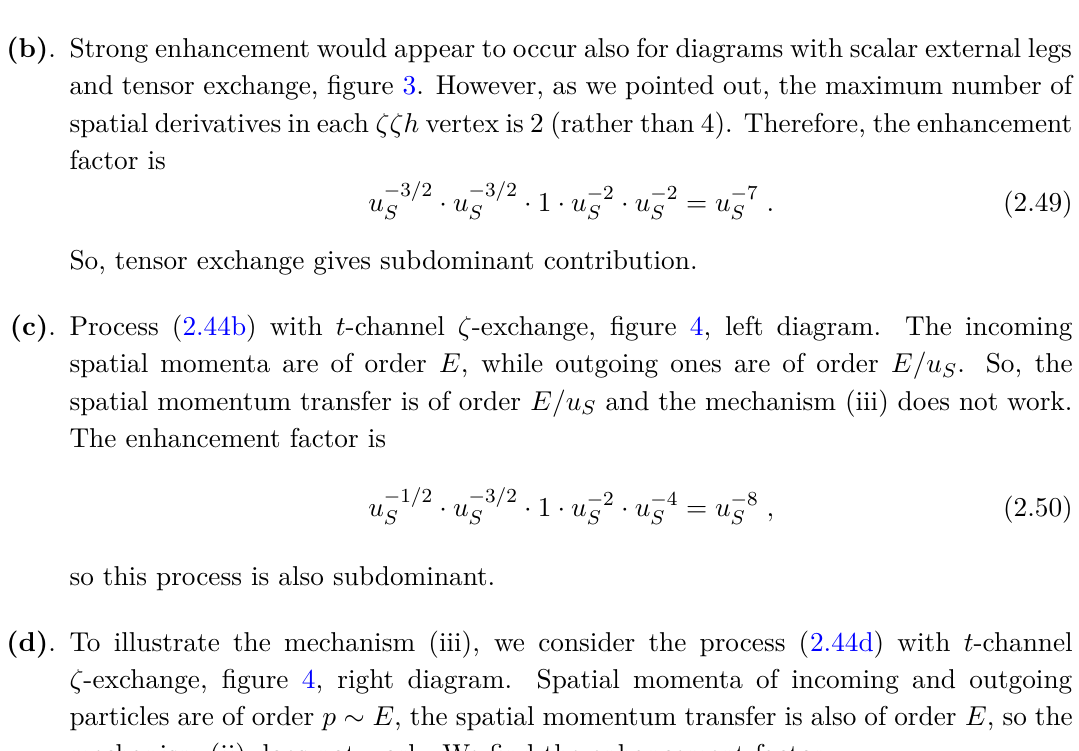
Figure 4 . Tree-level t-channel diagrams: cases (c) (left) and (d)